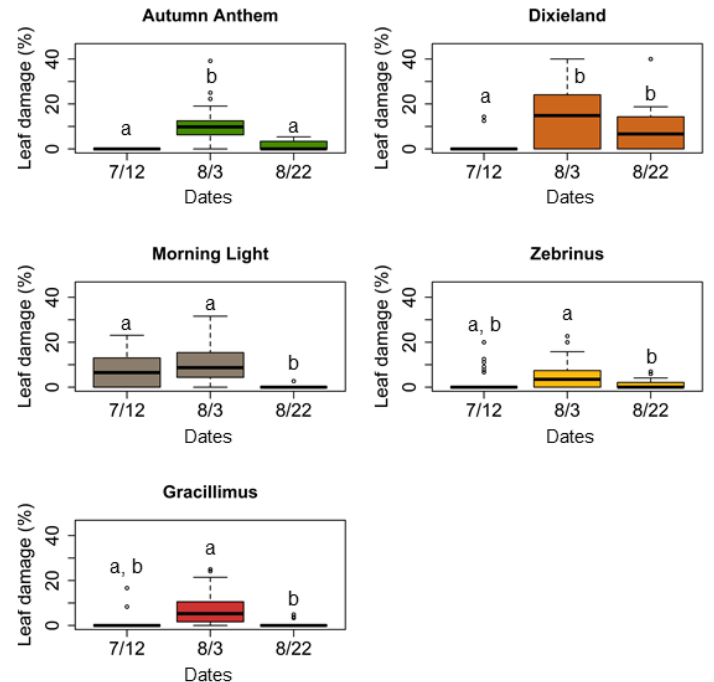
Figure 2. Comparisons of leaf damage in M. sinensis cultivars from grasshopper herbivory during herbivory assays in the field at the Western Maryland Research and Education Center (Keedysville, MD, USA), across three time points during the growing season in 2018. Box plots represent measurements of the percentage of apparent leaf damage; leaf damage measurements that do not share a letter is significantly different (Dunn test: p < 0.05; the Kruskal–Wallis test followed by post hoc Dunn test).